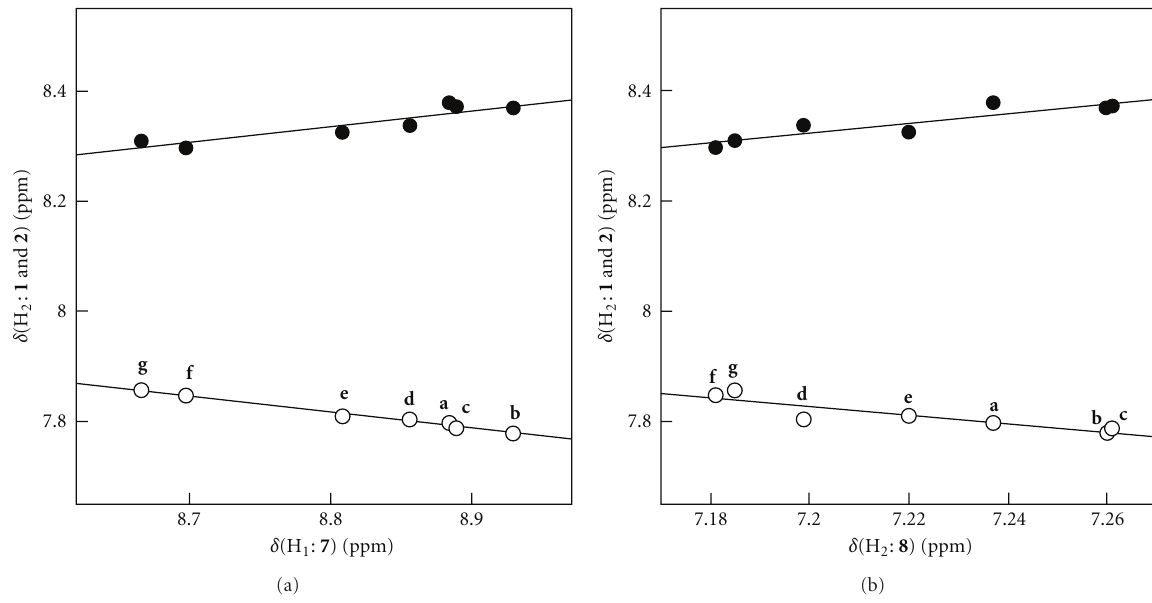
Figure 4: Plots of δ (H 2 : 1 and 2 ) versus δ (H 1 : 7 ) (a) and δ (H 2 : 8 ) (b): (cid:8) for 1 and for 2 .